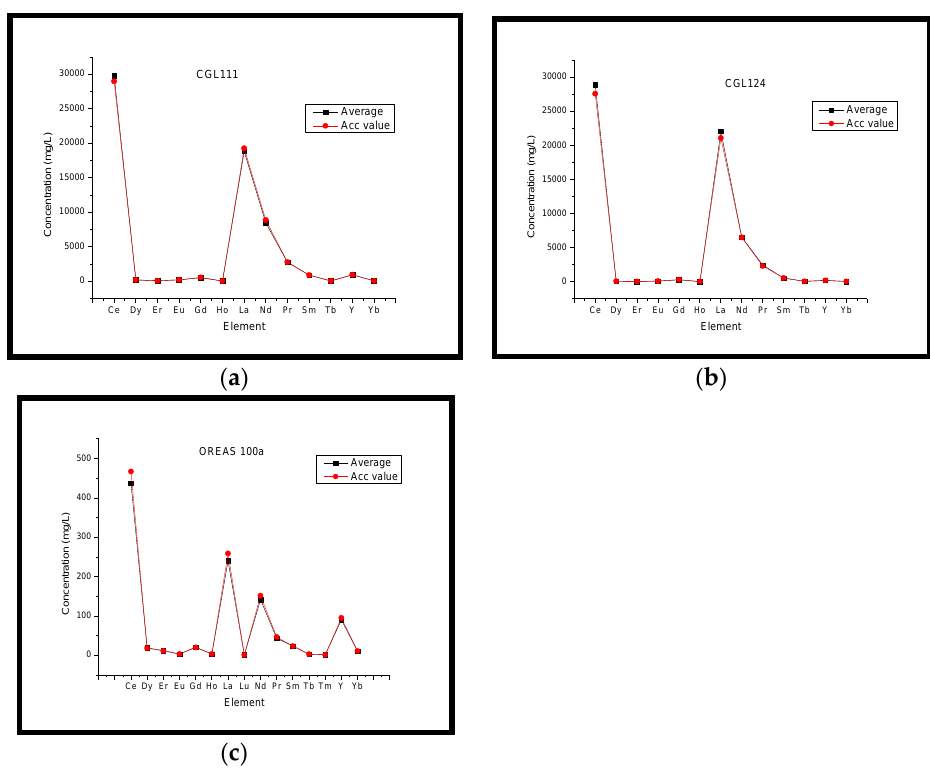
Figure 3. Evaluation of the method’s performance in the REE determination: ( a ) CGL 111; ( b ) CGL 124; ( c ) OREAS 100a.